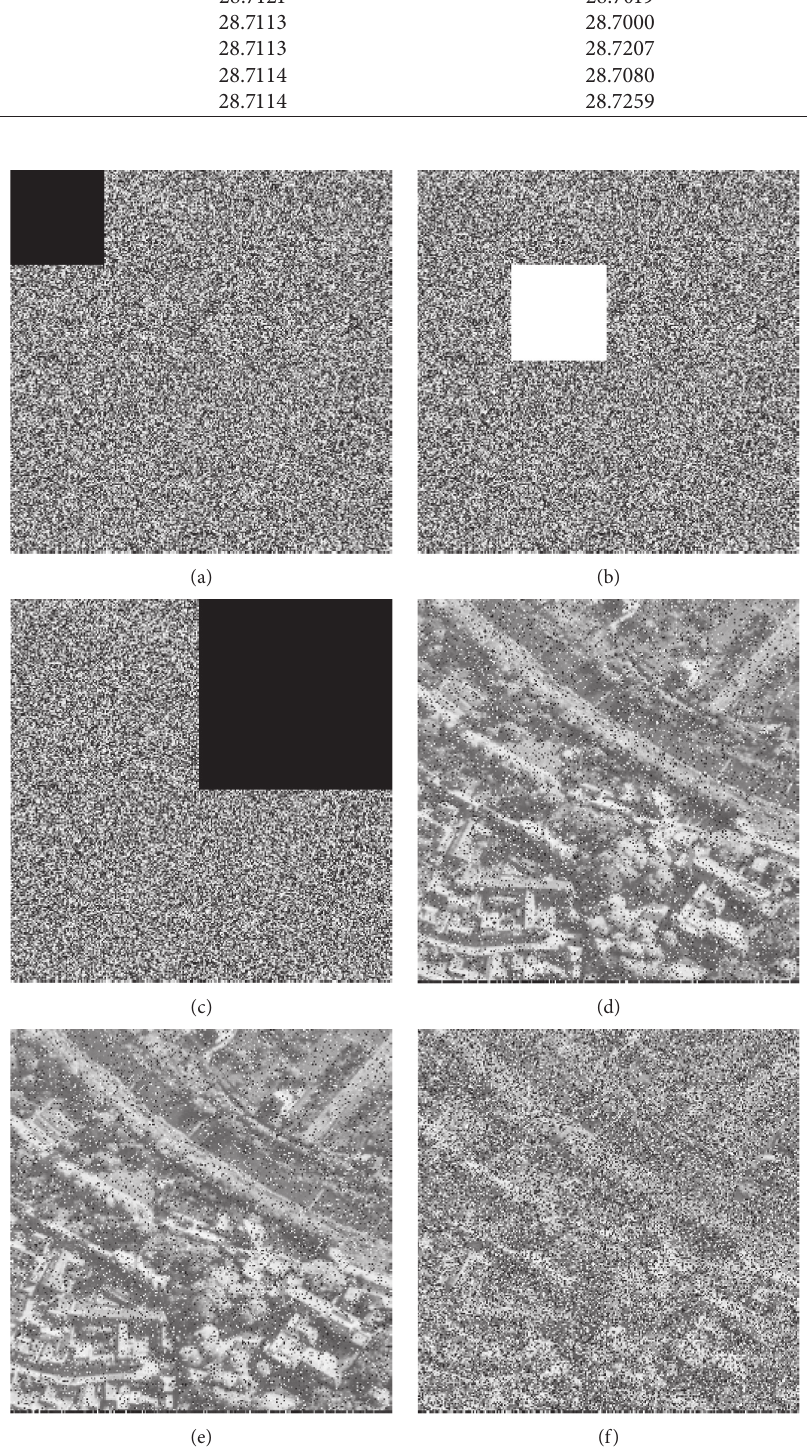
Figure 12: Data loss analysis: (a, b, c) the loss results by cutting ( 1/8 ) , ( 1/8 ) , and ( 1/4 ) of the encrypted image; (d, e, f) the deciphered images of (a), (b), and (c).